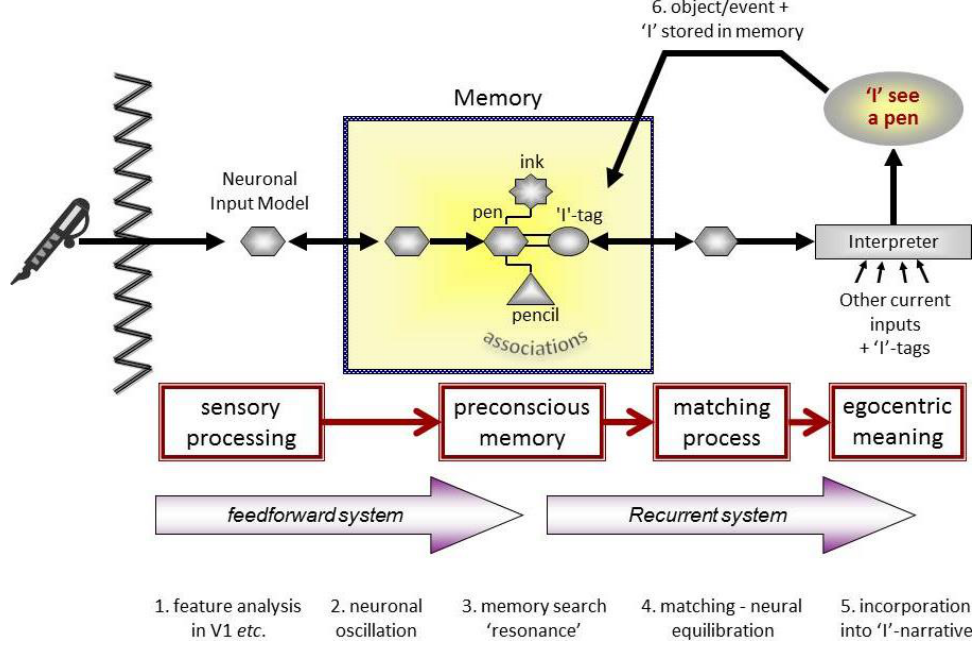
Figure 1. Schematization of the stages postulated to give rise to perception